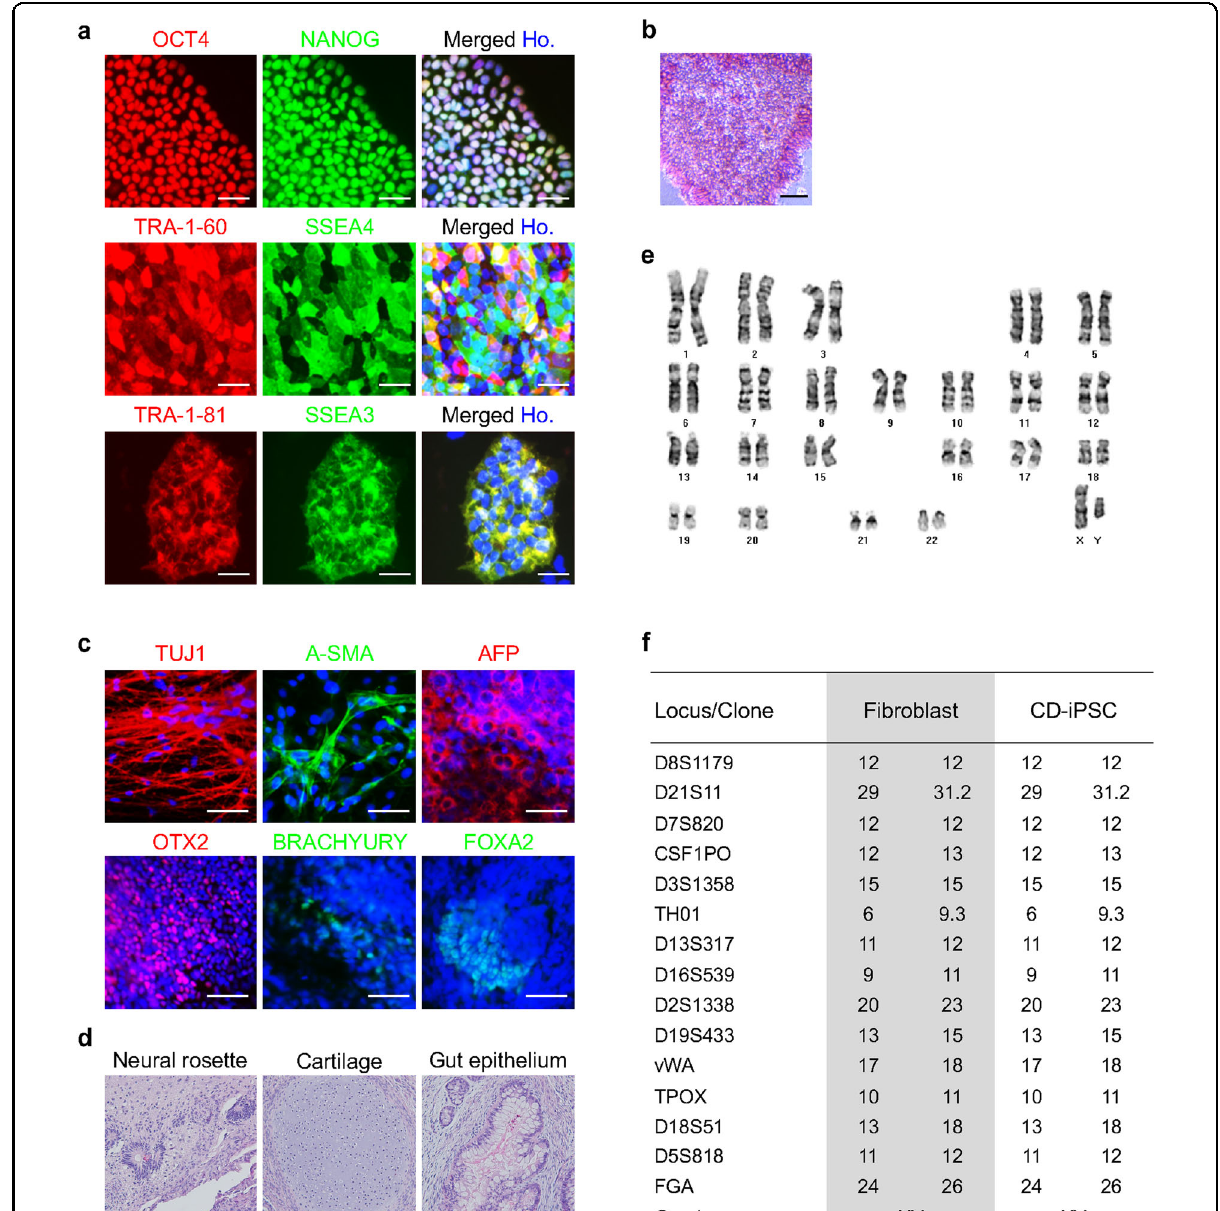
Fig. 4 Characterization of the selected EF-iPSCs treated with the CD/5-FC combination. The expression of various pluripotency markers was con fi rmed by immunocytochemistry ( a ) and AP staining ( b ). Scale bars represent 50 µm and 100 µm, respectively. c The in vitro differentiation potential was con fi rmed by immunocytochemistry of several markers in the three germ layers. The iPSCs were differentiated into EBs. Hoechst 33342 was used to stain the nuclei (blue). Scale bars represent 50 µm. d A teratoma formation assay was performed in immunode fi cient mice to con fi rm the in vivo differentiation potential. The resulting teratomas were stained with H&E. Scale bars represent 100 µm. e G-banding analysis con fi rmed that the selected iPSCs had normal human karyotypes. f STR analysis con fi rmed that the CD-iPSCs were derived from the original CRL2097 fi broblasts.